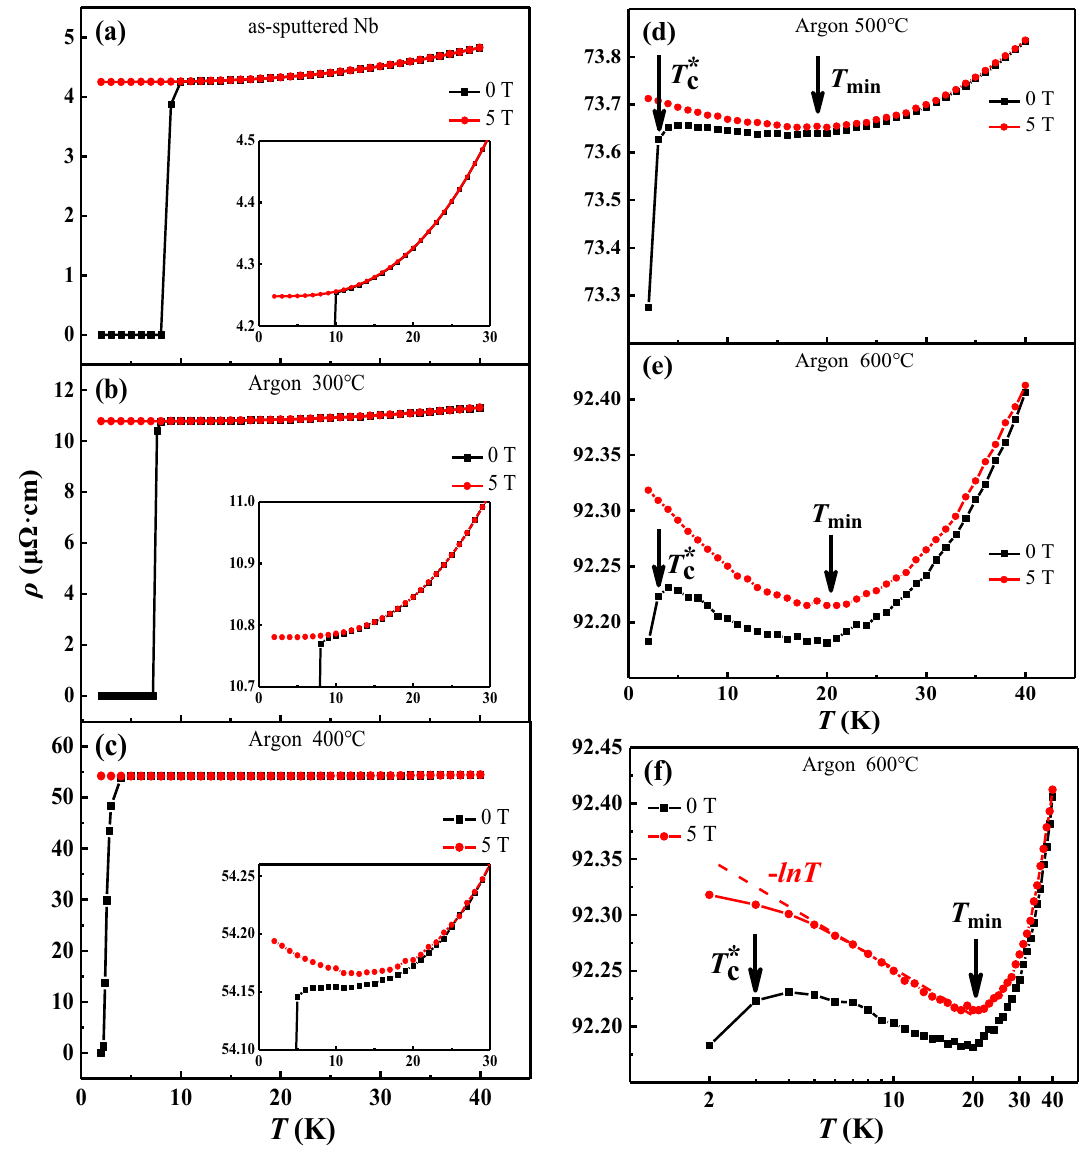
Figure 1. The effects of co-annealing with Fe in argon gas: ( a – e ) are the temperature dependence of resistivity ρ vs. T at 0 T and 5 T for as-sputtered Nb film, annealed at 300 ◦ C, 400 ◦ C, 500 ◦ C and 600 ◦ C, respectively. The annealing was done in flowing argon gas (pressure 50 Pa), for 60 min; ( f ) The data in ( e ) are re-plotted in a semi- log plot, with the x -axis being in logarithmic scale. The regime of − lnT is marked by a dashed straight line. The onset of superconducting transition T ∗ c is defined as the first drop of ρ